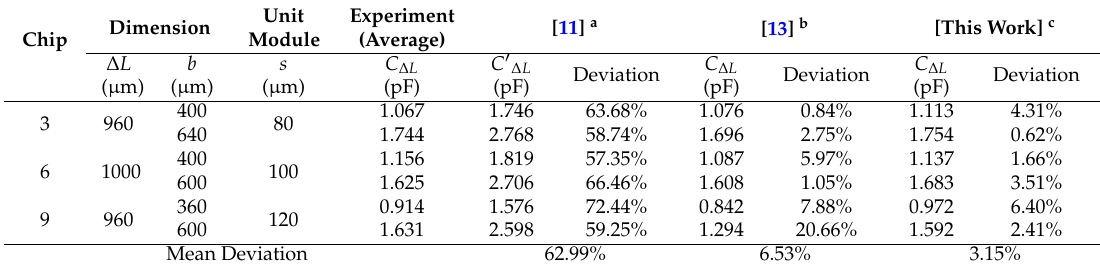
Table 9. Comparisons of capacitance between experiment and formulae ( µ =